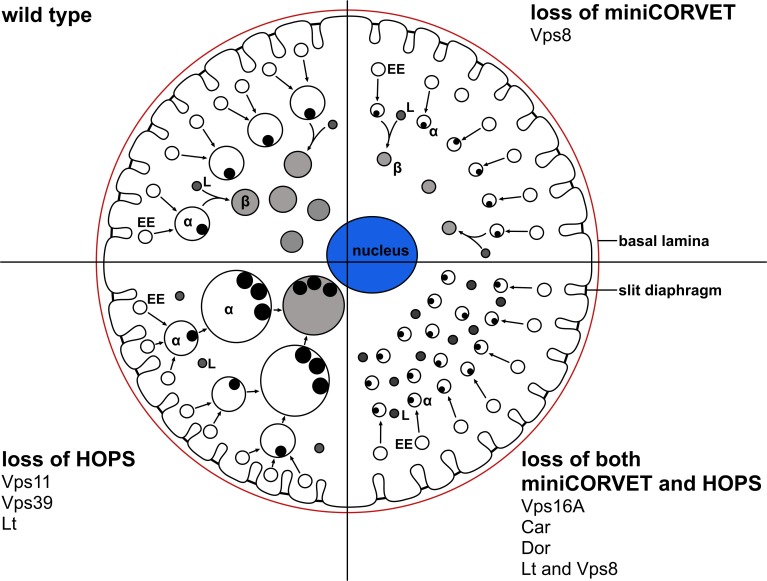
A cartoon illustrating garland nephrocytes in wild type, miniCORVET and/or HOPS loss-of-function animals.In control cells, fusion of early endosomes leads to formation of large electron lucent late endosomes (α-vacuoles) that contain a single core. These vacuoles mature into degradative endolysosomes (β-vacuoles), possibly by fusing with primary lysosomes. In cells lacking Vps8 (and as a result miniCORVET function), α-vacuoles remain small and fragmented due to insufficient early endosomal fusion events. In cells lacking HOPS function due to loss of Lt, Vps39 or Vps11, late endosomes fail to mature into degradative lysosomes. Note that α-vacuoles enlarge into enormous vacuoles containing multiple dense cores in these cells, likely because of the continuous input from early endosomal fusions that are supported by the tethers miniCORVET and Rbsn-5. Nephrocytes lacking both miniCORVET and HOPS function (due to loss of the shared subunits Vps16A, Car, Dor, or the double mutation of Vps8 and Lt) contain fragmented late endosomes as in the case of Vps8 mutants, and accumulate small dense granules (possibly Golgi-derived vesicles transporting lysosomal cargo). EE: early endosome, L: primary lysosome.